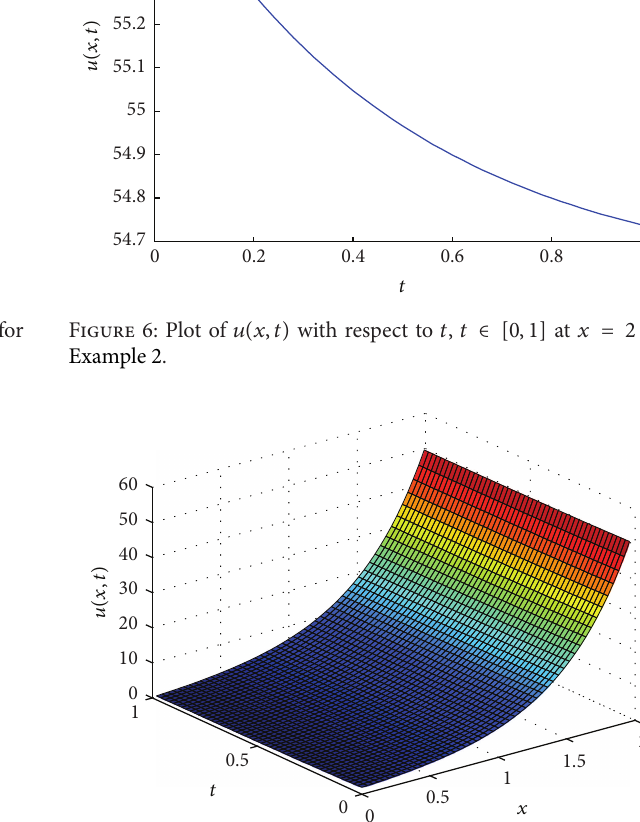
Figure 7: Depiction of solution 𝑢(𝑥, 𝑡) in the domain 𝑥 ∈ [0, 2] and 𝑡 ∈ [0,1] for Example